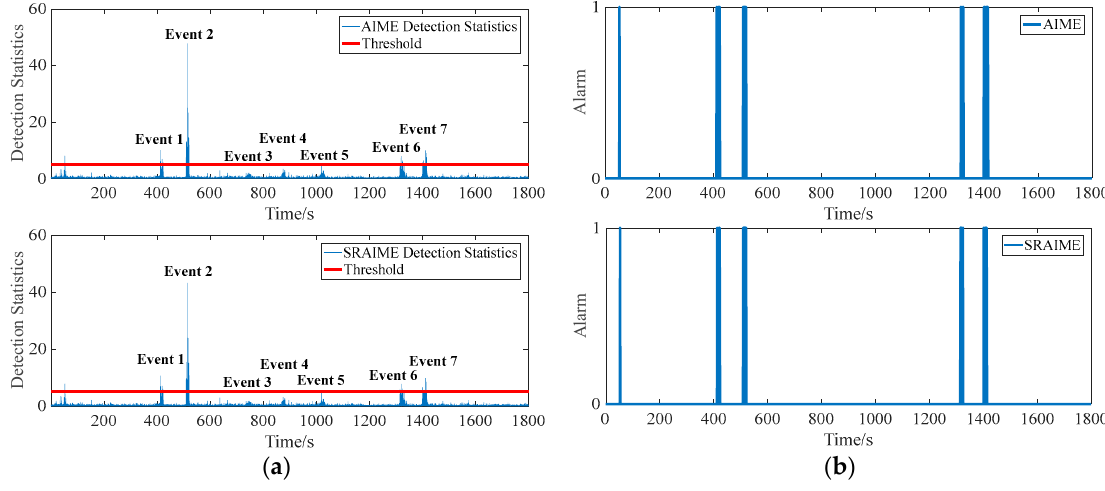
Figure 12. The slow-growing gross error detection results of Wilford Bridge by GNSS/accelerometer fusion: ( a ) Gross error detection statistics; ( b ) Gross error detection alarm condition.